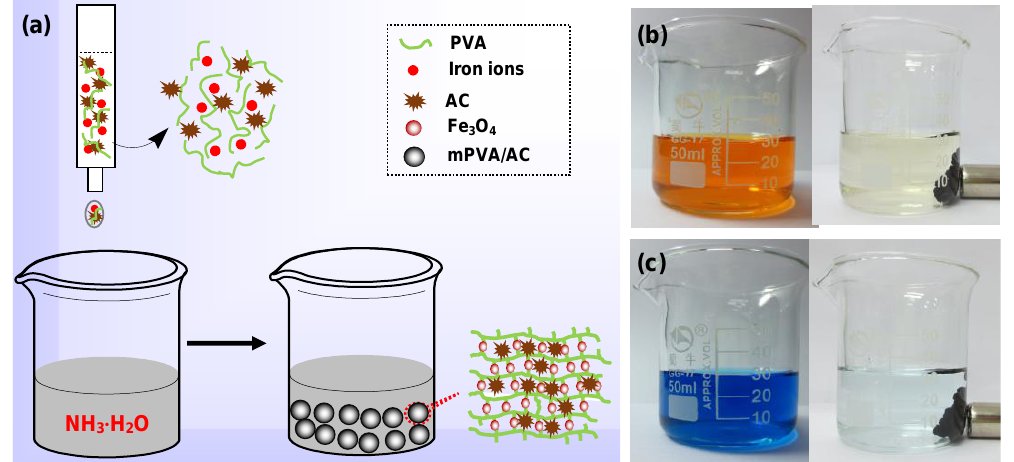
Figure 1. ( a ) Schematic illustration of the one-pot fabrication of magnetic poly(vinyl alcohol)/activated carbon composite gel (mPVA/AC CG). Photographs of aqueous solution of ( b ) MO and ( c ) MB before (left) and after (right) adsorbing by mPVA/AC CG.